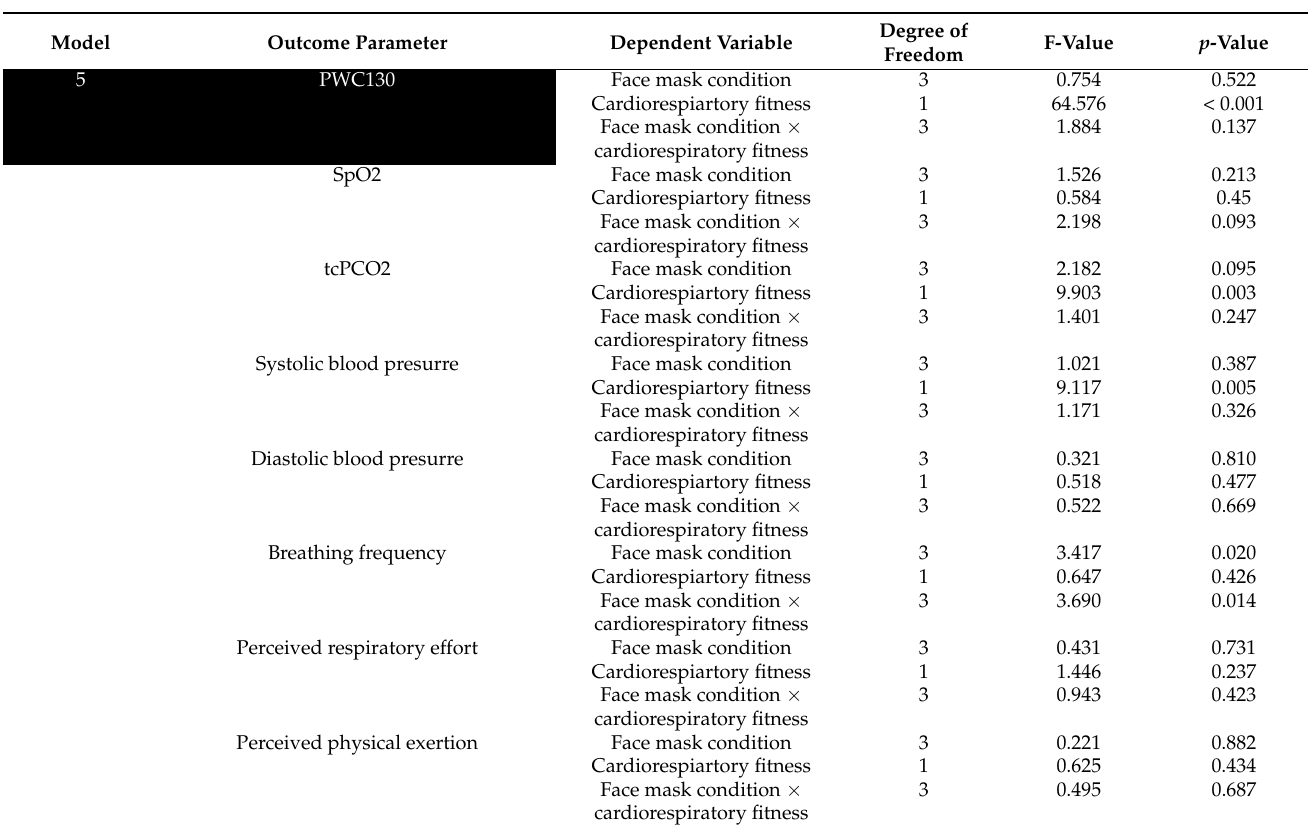
Table A8. Comparison of all face masks including mask condition, cardiorespiratory fitness, and the interaction term face mask condition x cardiorespiratory fitness—linear mixed model